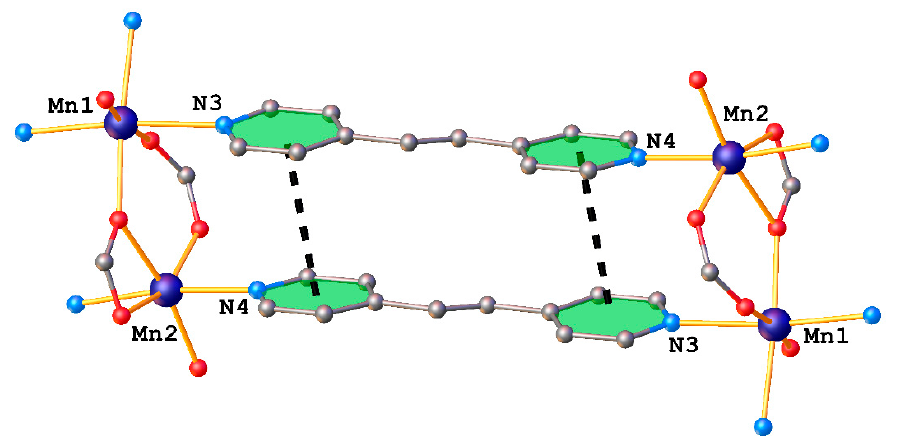
Figure 5. The fragment of the 3D coordination network showing π‐π interactions in compound 1 .